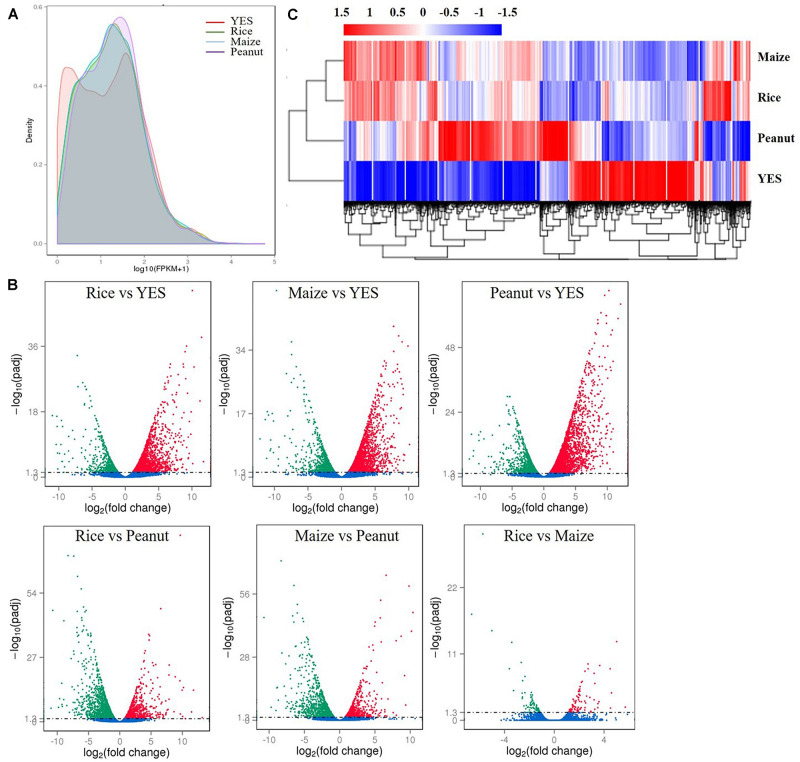
Transcriptome data analysis of A. flavus YC-15 in different substrates. (A) The fragments per kilobase of transcript per million mapped reads (FPKM) density distribution of A. flavus genes in different media. The final FPKM values are the mean values of three independent replicates. Different color curves stands for the diverse crops. (B) The volcano plots of the pairwise comparisons of different treatment. The differentially expressed genes (DEGs) in six comparison groups were showed as the red spots (upregulation) and green spots (downregulation), and no significantly changed genes were showed with blue. (C) Cluster analysis of DEGs in different media. The values of log10 (FPKM + 1) were transformed and clustered. The genes with similar function or in same metabolism pathway, would be clustered into one branch. High expressed genes were in red, and low expressed genes showed with blue.